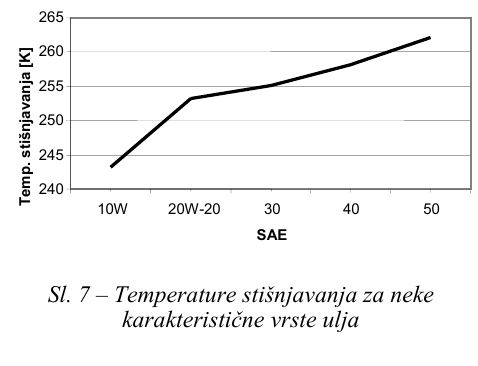
Sl. 7 – Temperature stišnjavanja za neke